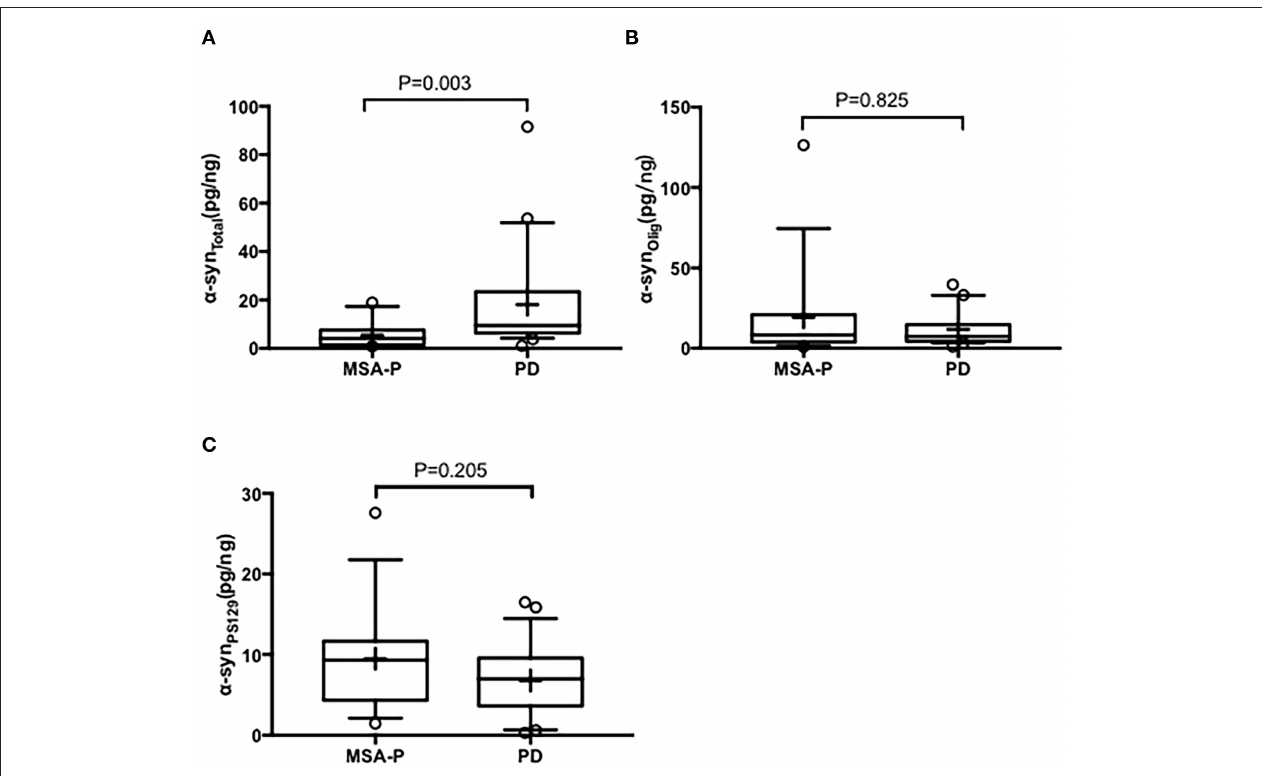
FIGURE 1 | Box plot of total α -syn (A) , oligomeric α -syn (B) , and phosphorylated-ser129, α -syn (C) levels in EVs of saliva between MSA-P and PD. This box plot depicted the median and quartiles. “ + ” represent the mean